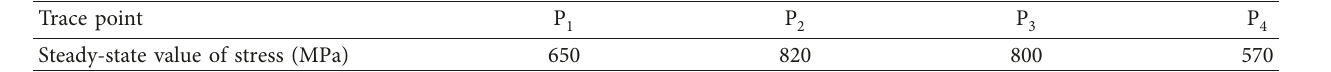
Table 6: Steady-state residual stresses at the trace points.